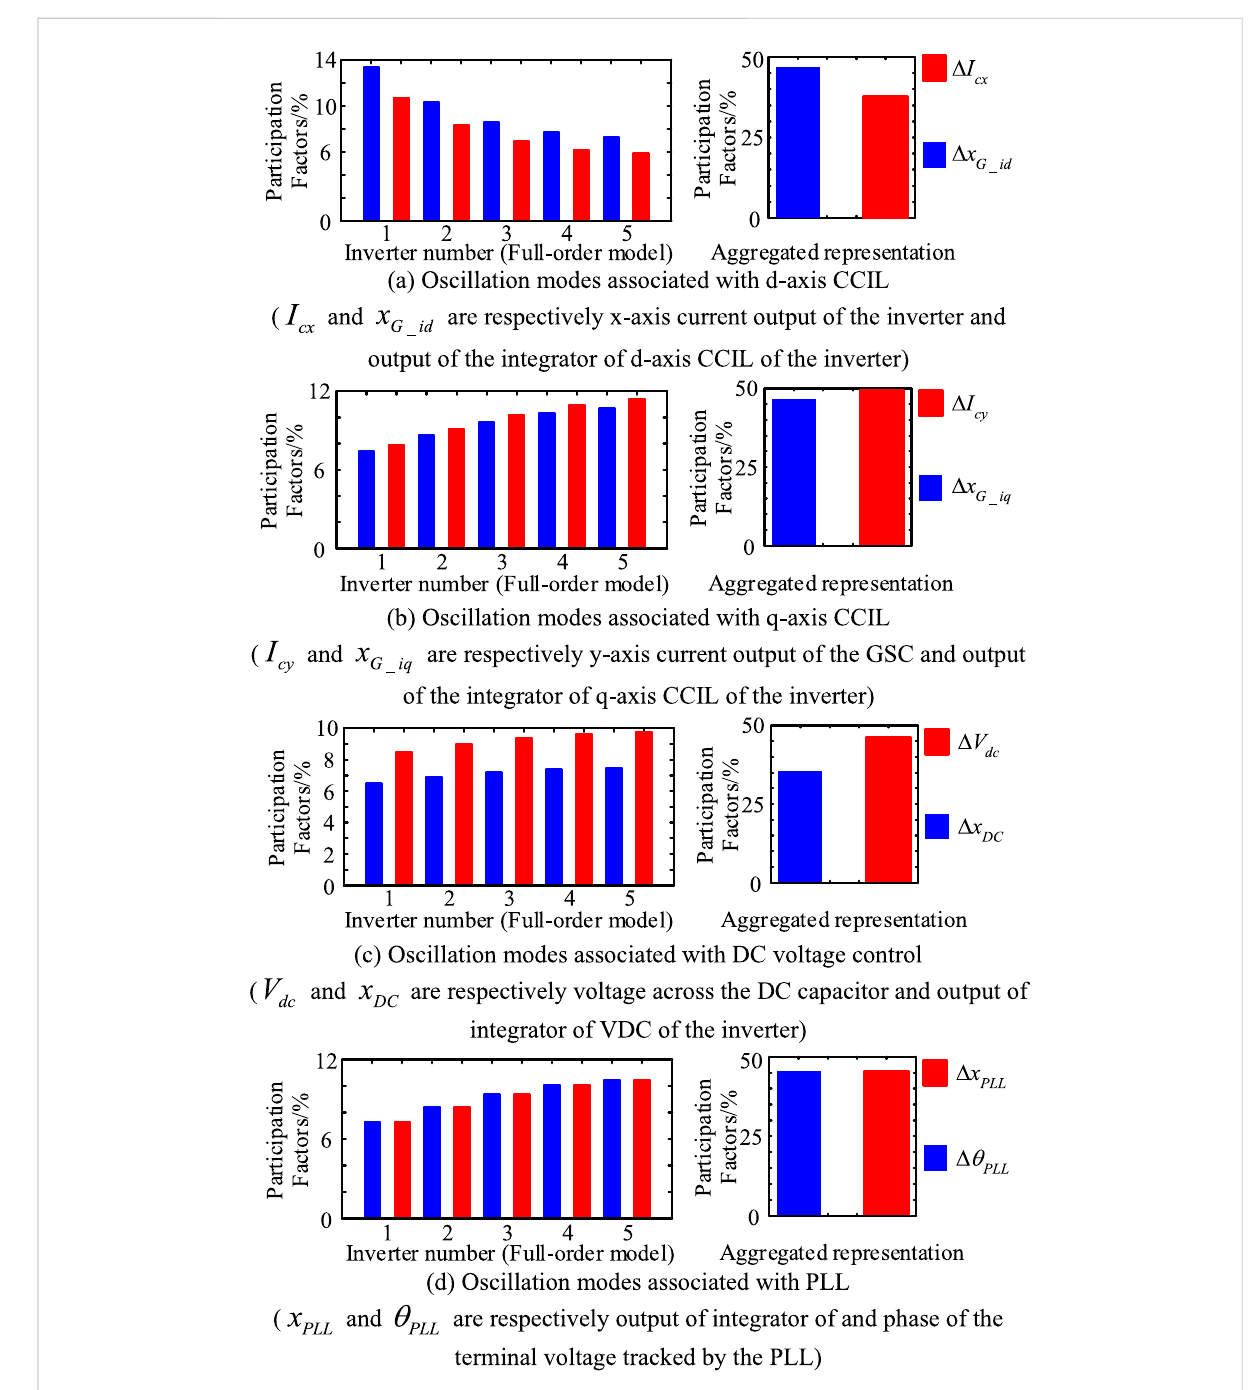
FIGURE 5 Computational results of participation factors (case study 1). (A) Oscillation modes associated with d-axis CCIL ( I cx and x G id are, respectively, the x -axiscurrentoutputoftheinverterandoutputoftheintegratorofd-axisCCILoftheinverter). (B) Oscillationmodesassociatedwithq-axisCCIL ( I cy and x G iq are, respectively, the y -axis current output ofthe GSC and outputof the integrator of q-axis CCIL ofthe inverter). (C) Oscillation modes associated with DC voltage control ( V dc and x DC are, respectively, the voltage across the DC capacitor and output of integrator of VDC of the inverter). (D) Oscillationmodesassociatedwith PLL( x PLL and θ PLL are,respectively, theoutputofintegratorandphaseoftheterminalvoltagetracked by the